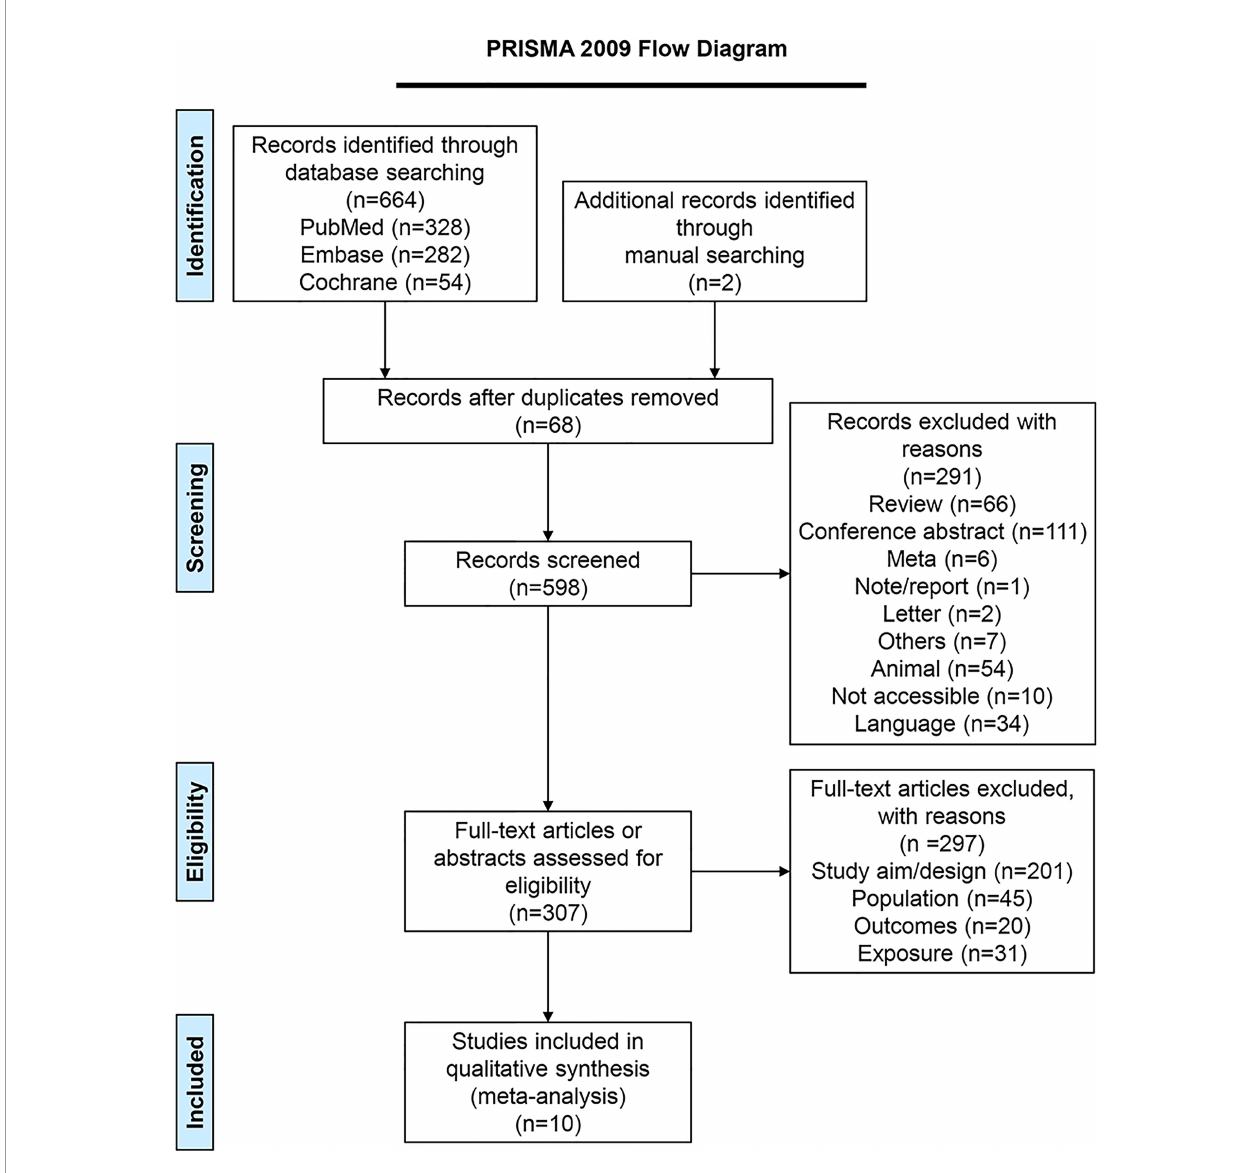
FIGURE 1 | PRISMA 2009 Flow